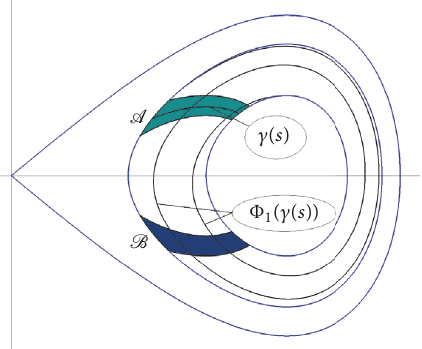
Figure 4: The present figure describes how a path 𝛾(𝑠) crossing A from A − 𝑙 to A − 𝑟 is stretched by Φ 1 to a path Φ 1 (𝛾(𝑠)) which crosses twice B from B − 𝑙 to B − 𝑟 . As in Figure 2 we have considered 𝑓(𝑥) = = 2 , 𝑉 = 1. For this example we have taken 𝑇 𝑥 3 and 𝑉 1 2